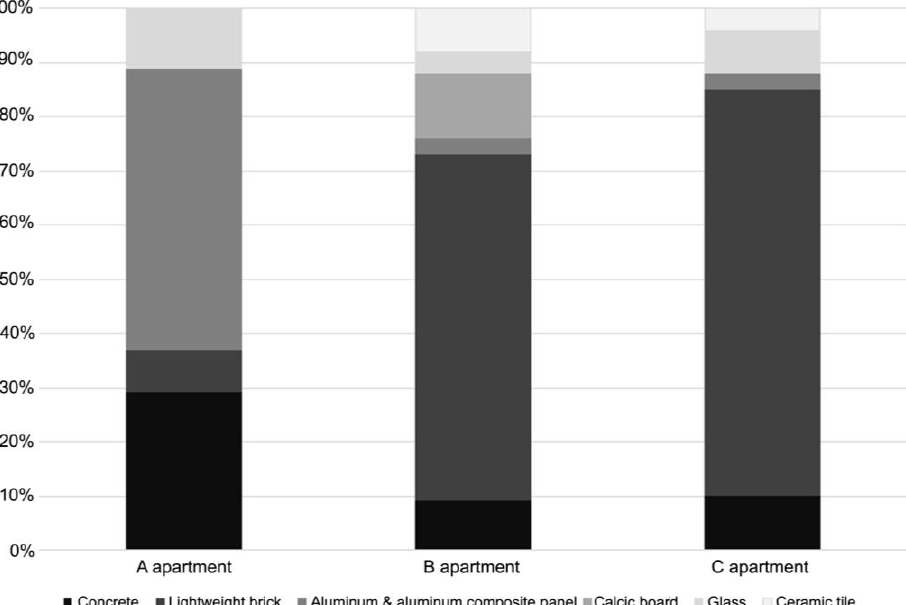
Fig. 2. Cladding material composition of the 3 selected units in 3 apartment